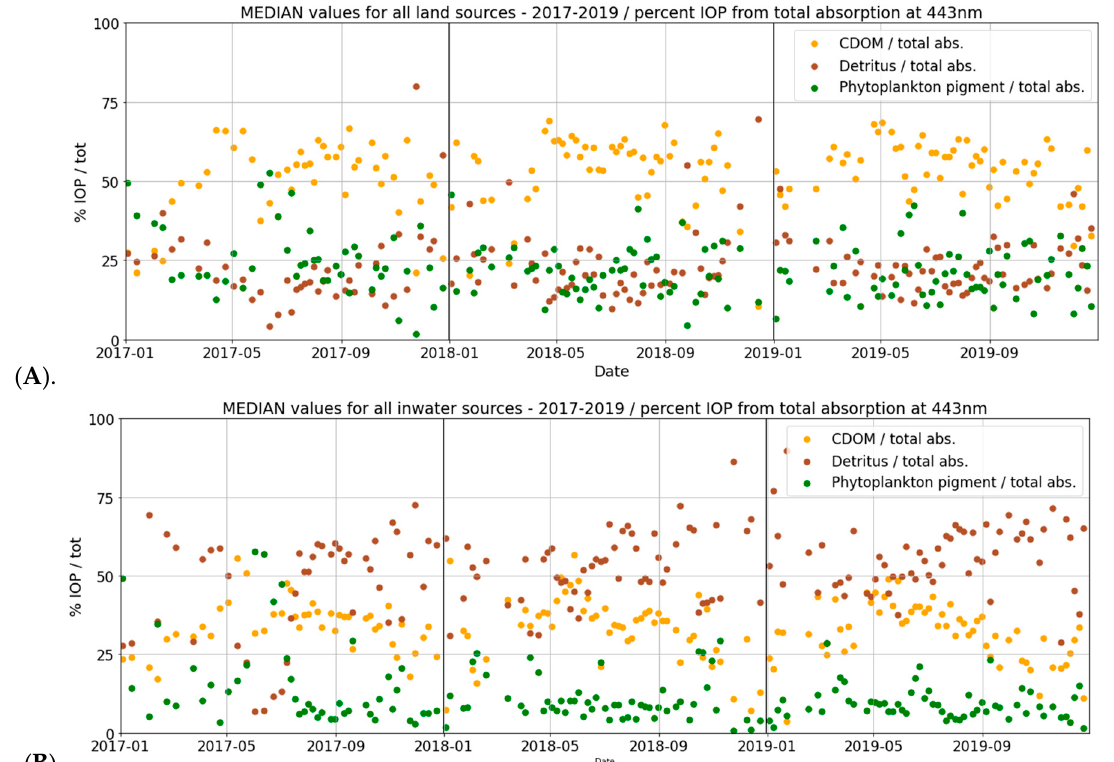
Figure 5. Time series of the percent contribution of each IOP fraction to the total absorption at 443 nm (CDOM—yellow, detritus—brown, phytoplankton pigment—green); ( A ). The median values of all fluvial points and those connected to wastewater outfall (groups 1 and 2); ( B ). The median value of all inwater study points, for all sea depths (groups 3, 4 and 5).